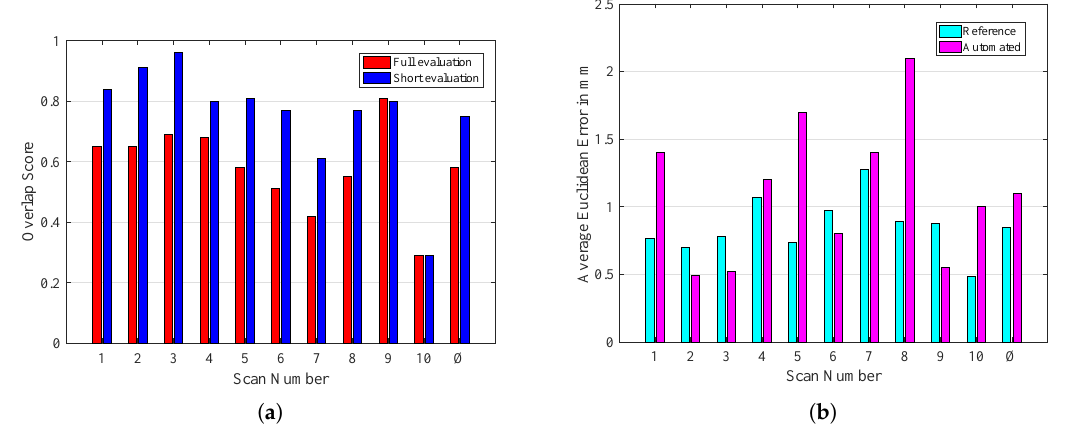
Figure 4. Evaluation results of the centerline extraction and curved planar reformation. ( a ) Overlap of the automated coronary centerline extraction. ( b ) Mean absolute error of the curved planar